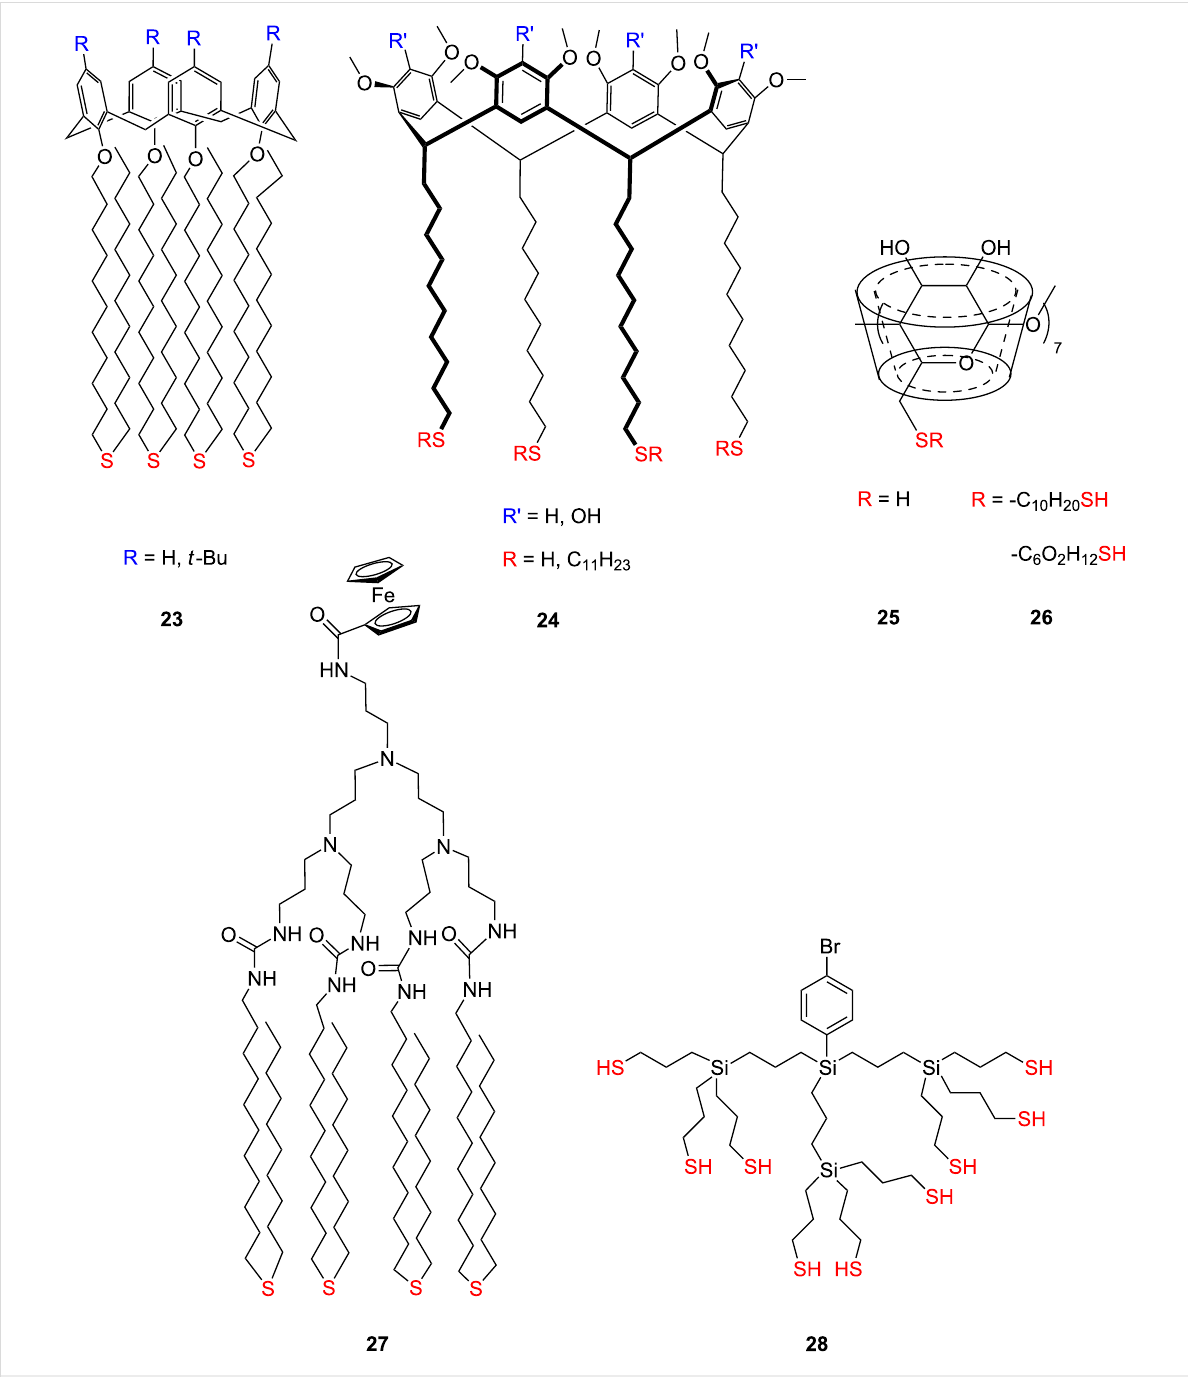
Figure 11: Structure of aliphatic multipodal adsorbates.